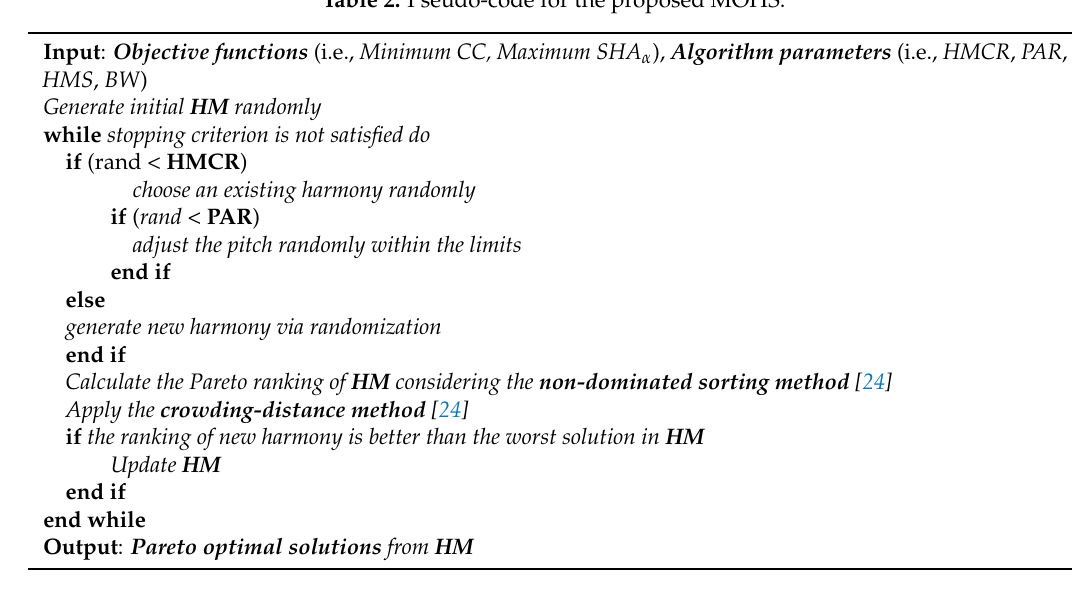
Table 2. Pseudo-code for the proposed